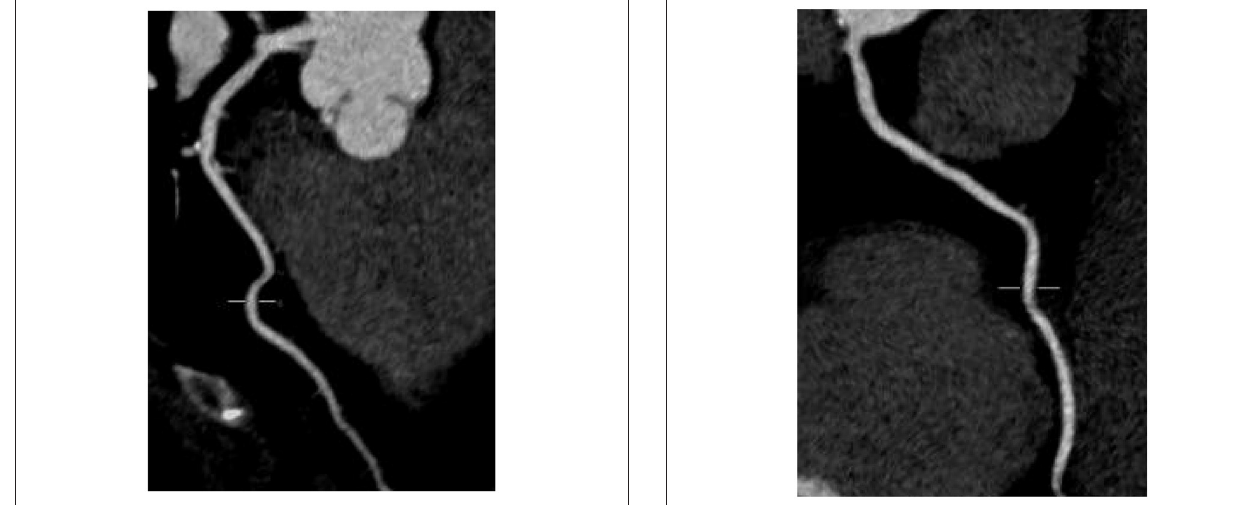
FIGURE 2 | Typical image of right coronary artery curved planar reconstruction in the control